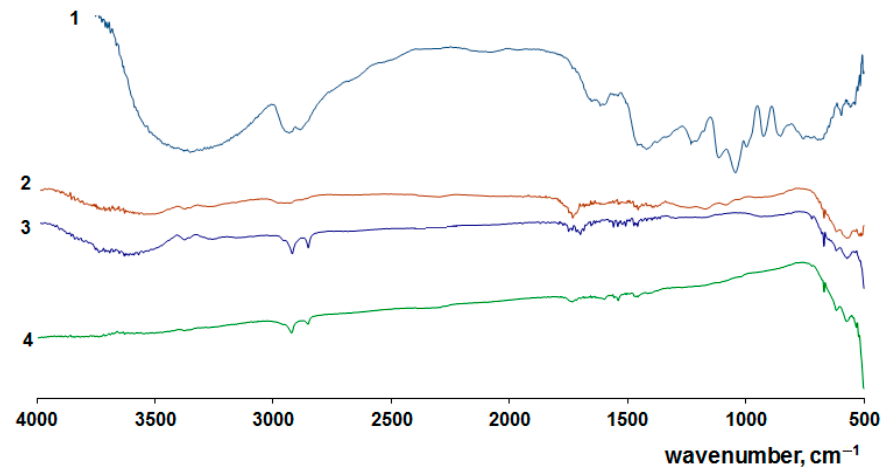
Figure 6. IR spectra of CR (curve 1) and its decomposition products under the UV irradiation of